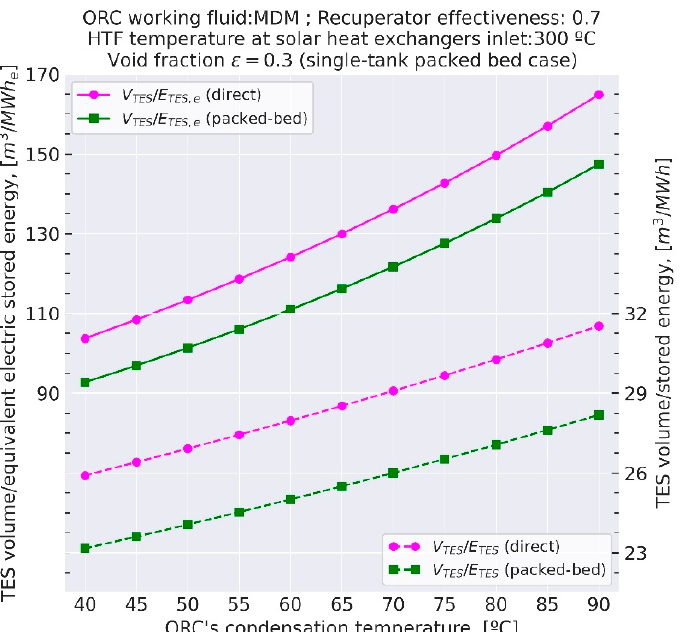
Figure 8. Storage medium volume per unit of stored energy as a function of the ORC’s condensing temperature.